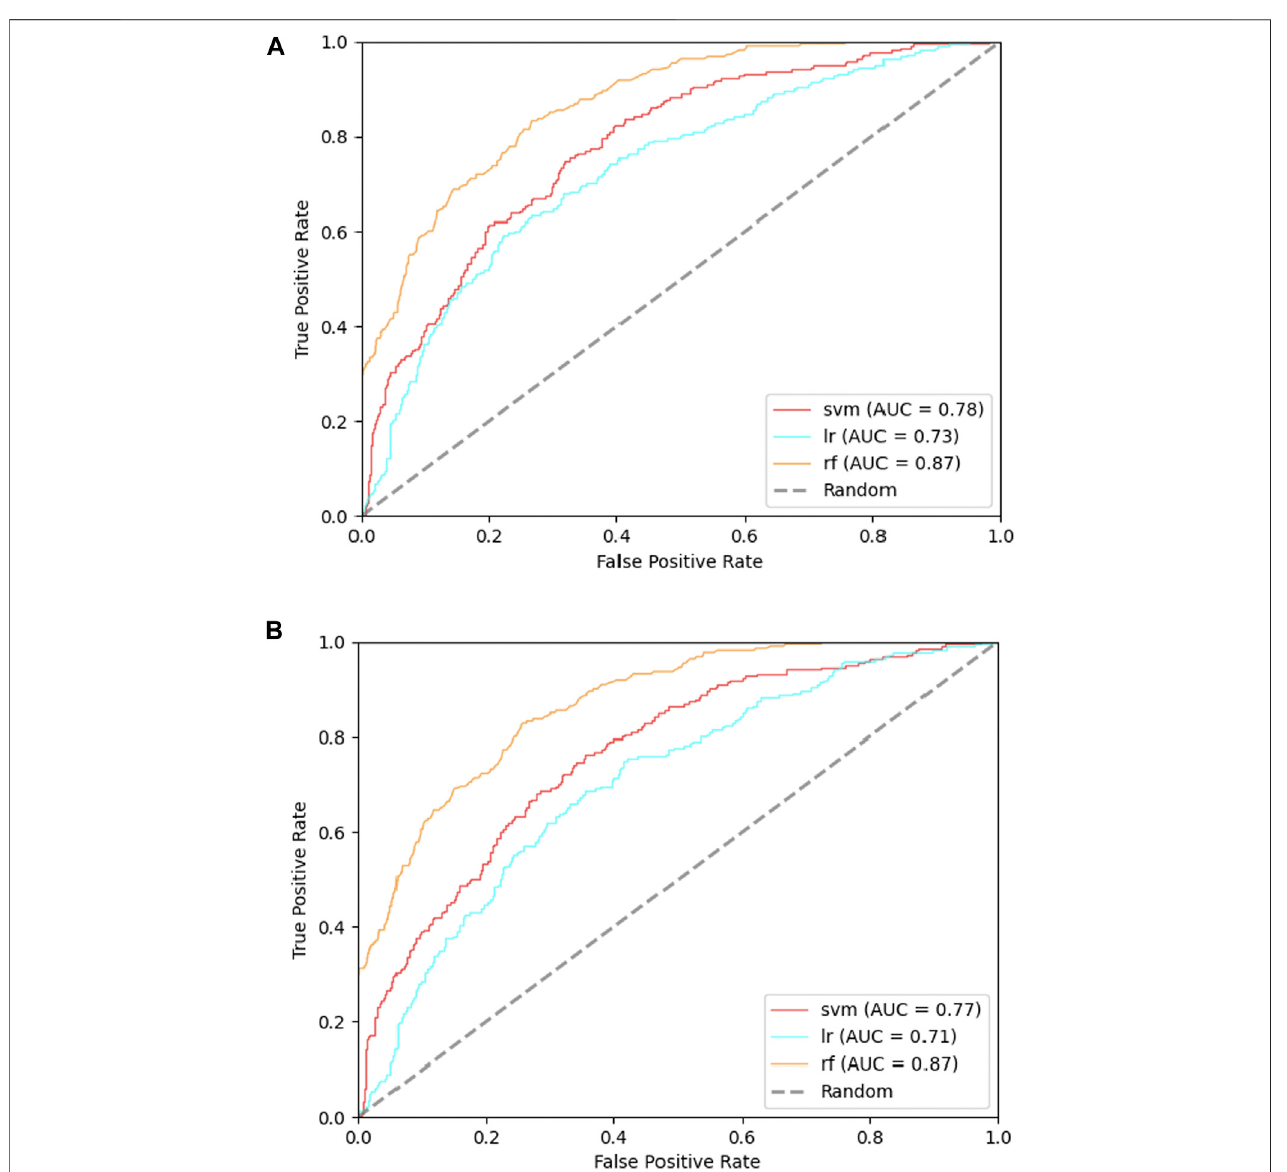
FIGURE 7 | ROC curves of incorporated features in the cases with or without RRPC incorporated: (A) incorporated with RRPC and (B) incorporated without RRPC.